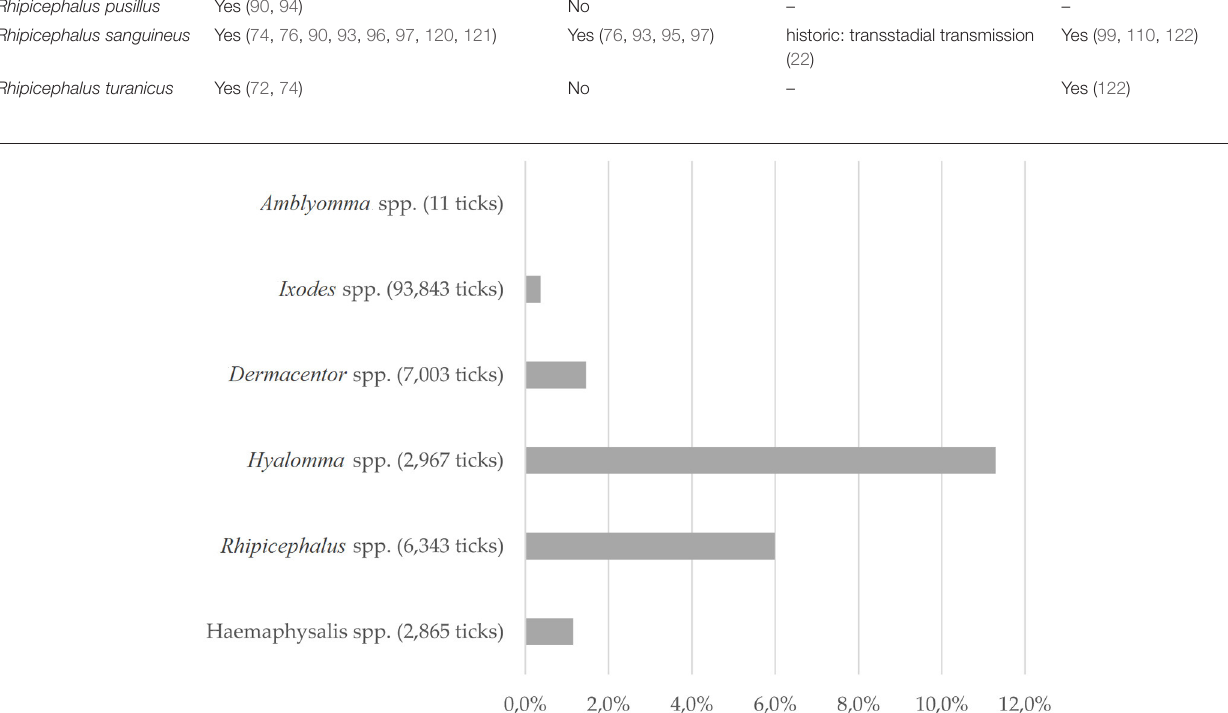
FIGURE 3 | Tick species: Proportion of C. burnetii -positive ticks of the ticks tested, depending on tick genera. For 2,233 ticks, only total numbers were described.